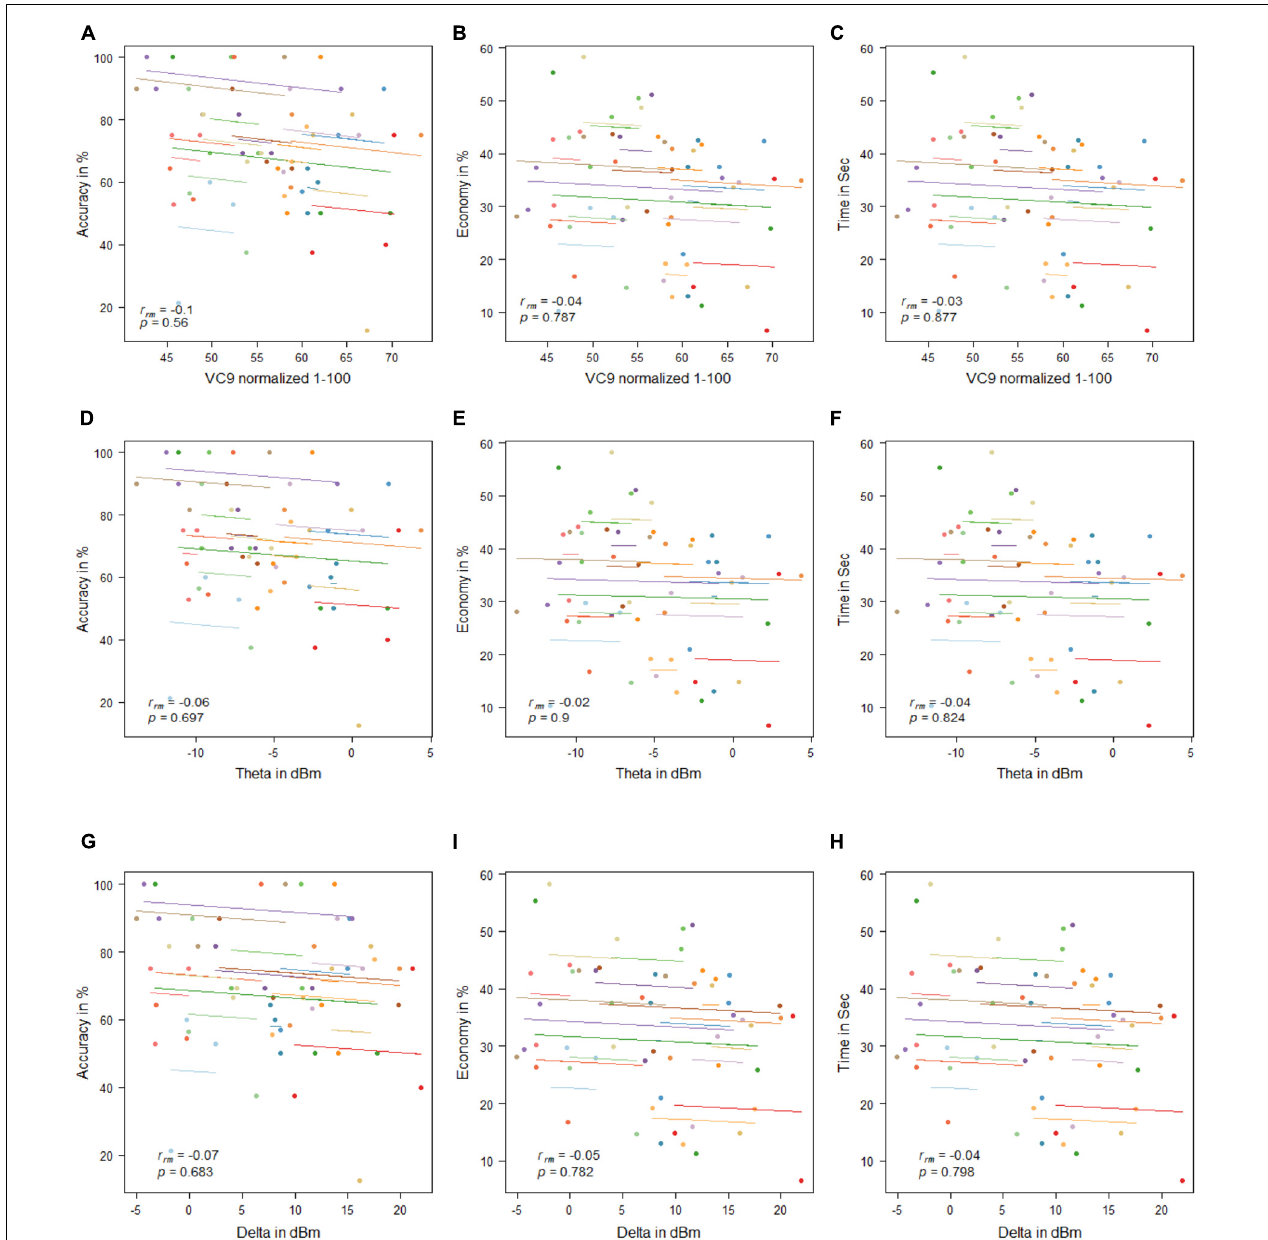
FIGURE 11 | Mean activity of VC9 as a function of accuracy (A) , economy (B) , and time (C) ; theta as a function of accuracy (D) , economy (E) , and time (F) ; and delta as a function of accuracy (G) , economy (H) , and time (I) per trial and participant obtained in Experiment 3 ( n = 19). R rm and p- values presented.